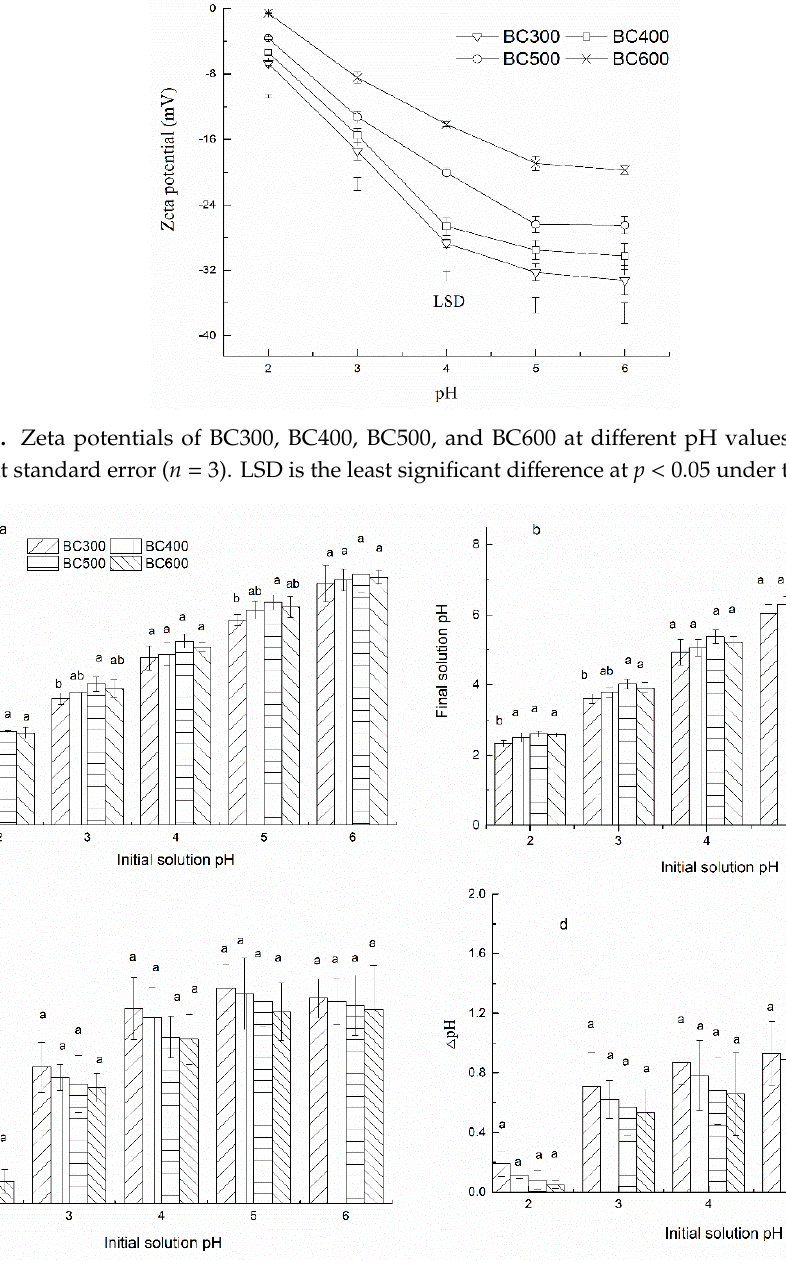
Figure 4. Effect of initial solution pH on the final pH and △ pH ( △ pH = Cu(II) and Zn(II) free solutions pH—the final pH) during the sorption of Cu(II) ( a , c ) and Zn(II) ( b , d ) by BCs produced at different temperatures (initial Cu(II) concentration 64 mg L −1 , initial Zn(II) concentration 65 mg L −1 ; reaction temperature 25 °C; BC dosage 5 g L −1 ; contact time 1440 min). Error bars represent standard error ( n = 3). Different letters above bars within the same pH condition indicate significant differences among BCs ( p < 0.05).